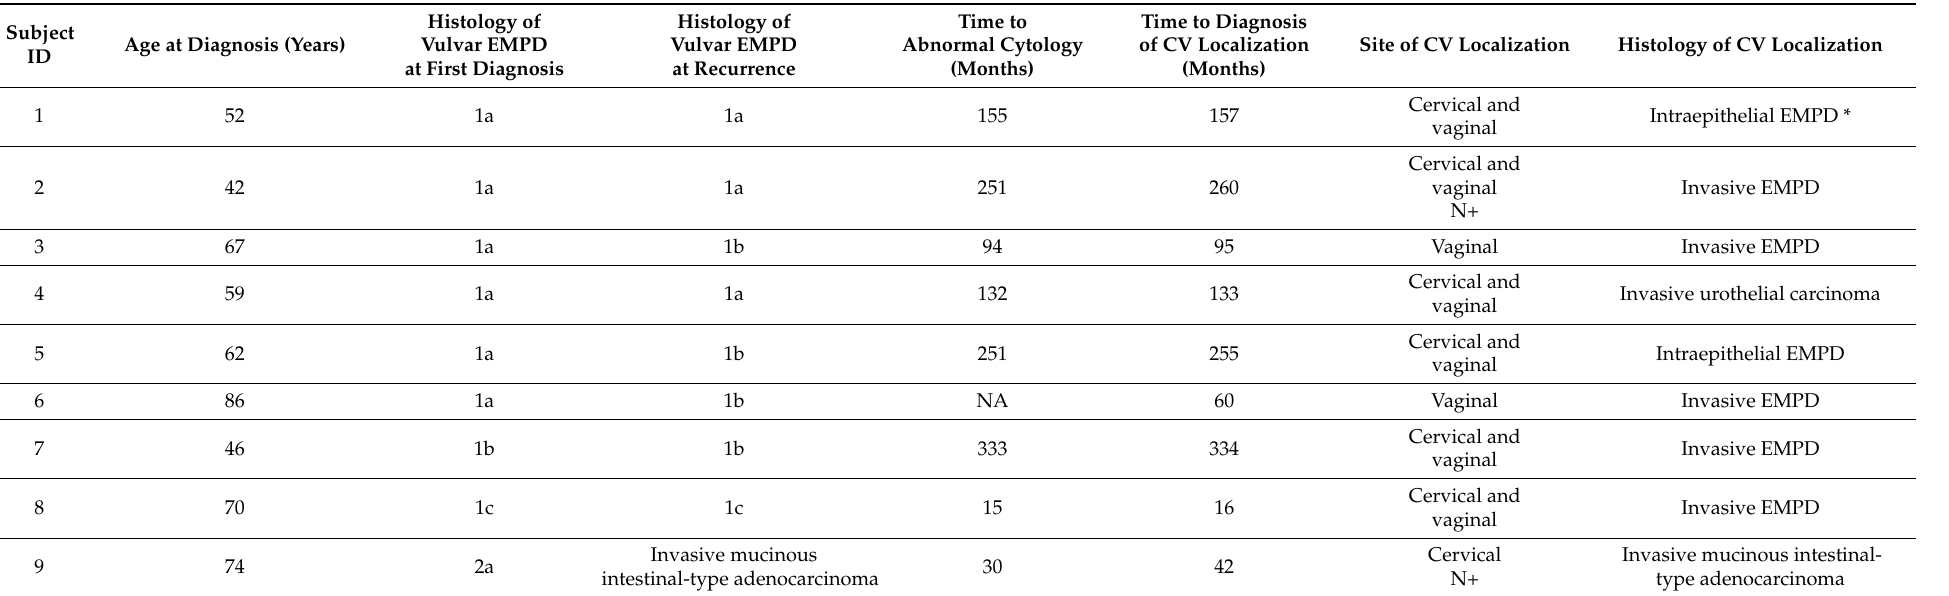
Table 2. Principal characteristics of women with cervico-vaginal (CV) localization of vulvar EMPD (N =